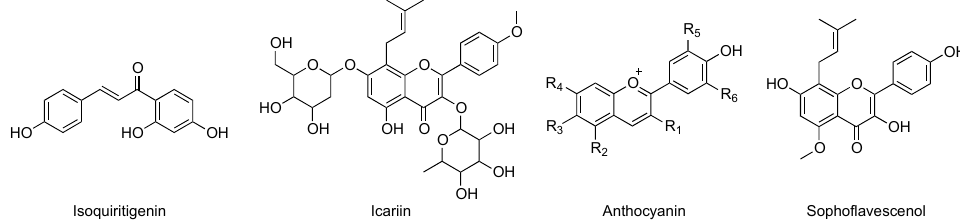
Figure 6. Chemical structures of some of the known c-GMP-specific PDE inhibitors.